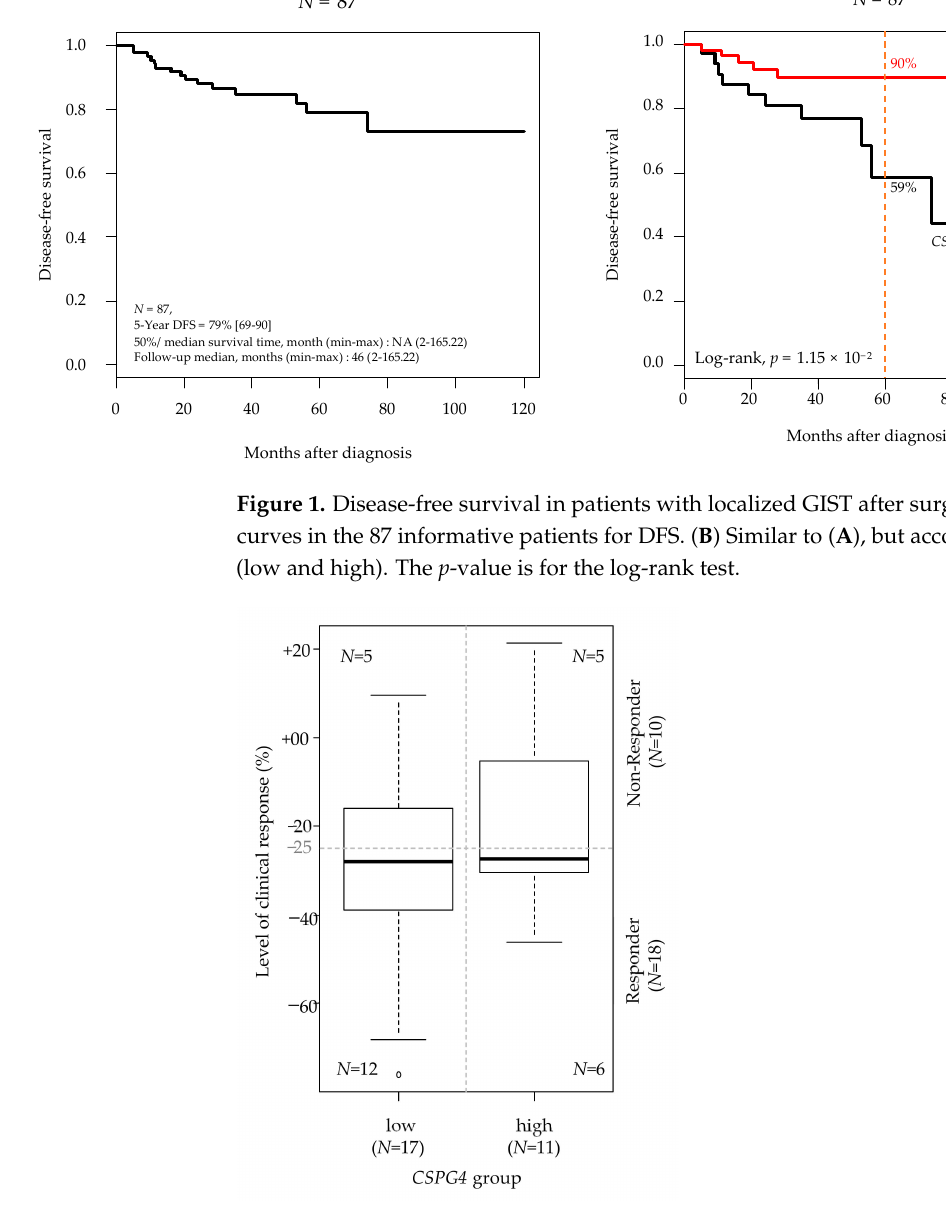
Figure 2. Correlation between CSPG4 expression and the response to imatinib. Correlation between the two CSPG4-based groups (high and low; N = 28) and the level of clinical response to neoadjuvant imatinib assessed as a continuous variable (box plot). The horizontal dashed line indicates the cut-off of tumor shrinkage that defines the responder status. The figures within the box plot indicate the number of patients in each of the four Figure 3. Correlations between CSPG4 expression and immune features. Forrest plot of correlations between CSPG4-high (left) and -low (right) expression and immune features, including the composition and functional orientation of the immune infiltrate according to the Bindea’s immunome, the Immunologic Constant of Rejection signature, T cell-inflamed signature (TIS) and tertiary lymphoid structures (TLS) enrichment signatures, the immune cytolytic activity score, the antigen processing/presentation machinery (APM) score, and ESTIMATE tool analysis for immune or stromal infiltrating cells. The p -values are for the logit link test.